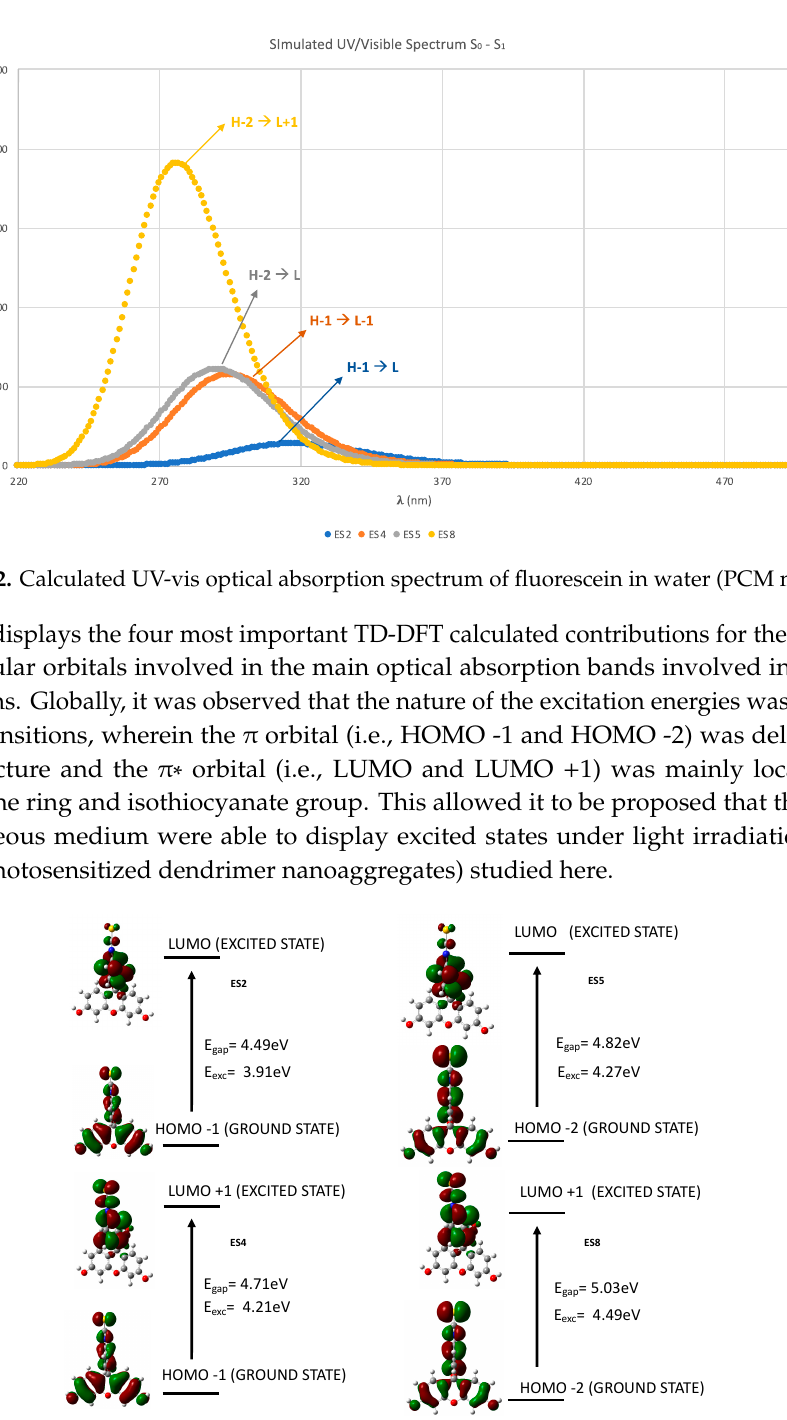
Figure 11. Schematic representation of ( a ) fluorescein and ( b ) geometry of the ground state (S 0 ) of the DFT calculation using the PCM solvation model.